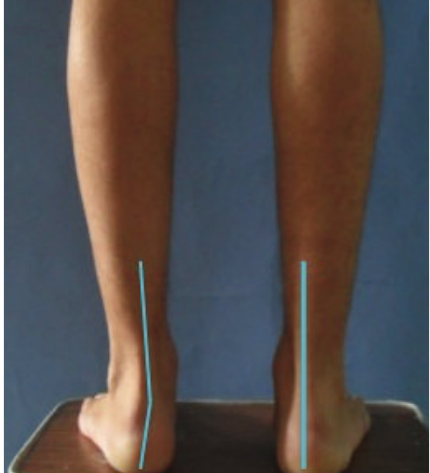
Figure 2: Stance position. Solid lines were marked on the skin, and dashed lines have been added to the photograph to identify the tibial angle and the calcaneal stance.